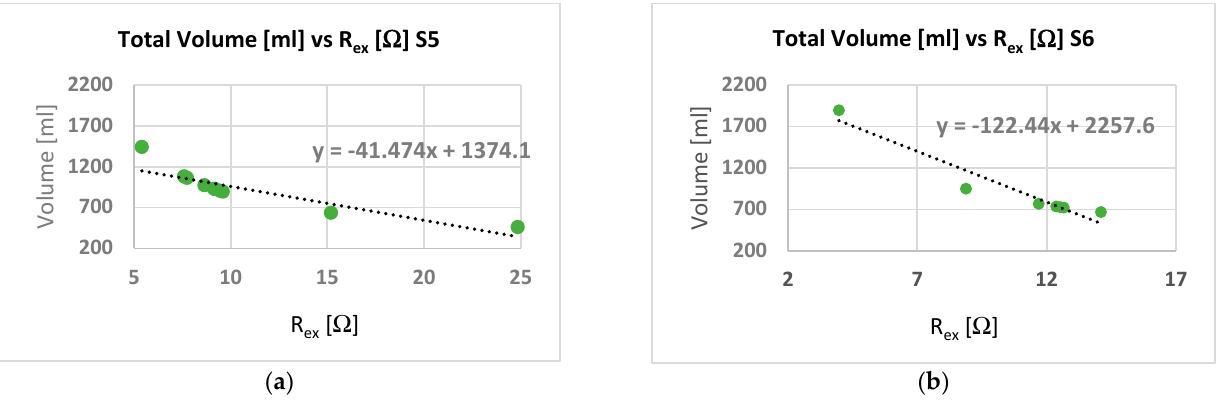
Figure 11. Total volume estimation versus extracellular resistance, R ex ( R_0 ) for unhealthy per- sons.